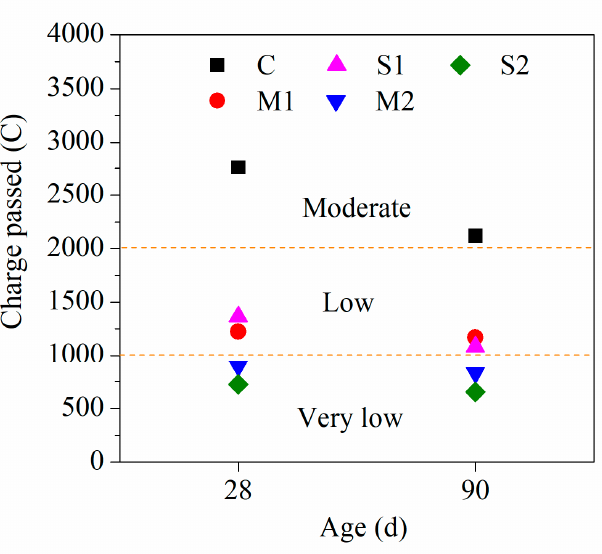
Figure 4. Chloride ion penetrability of concrete.